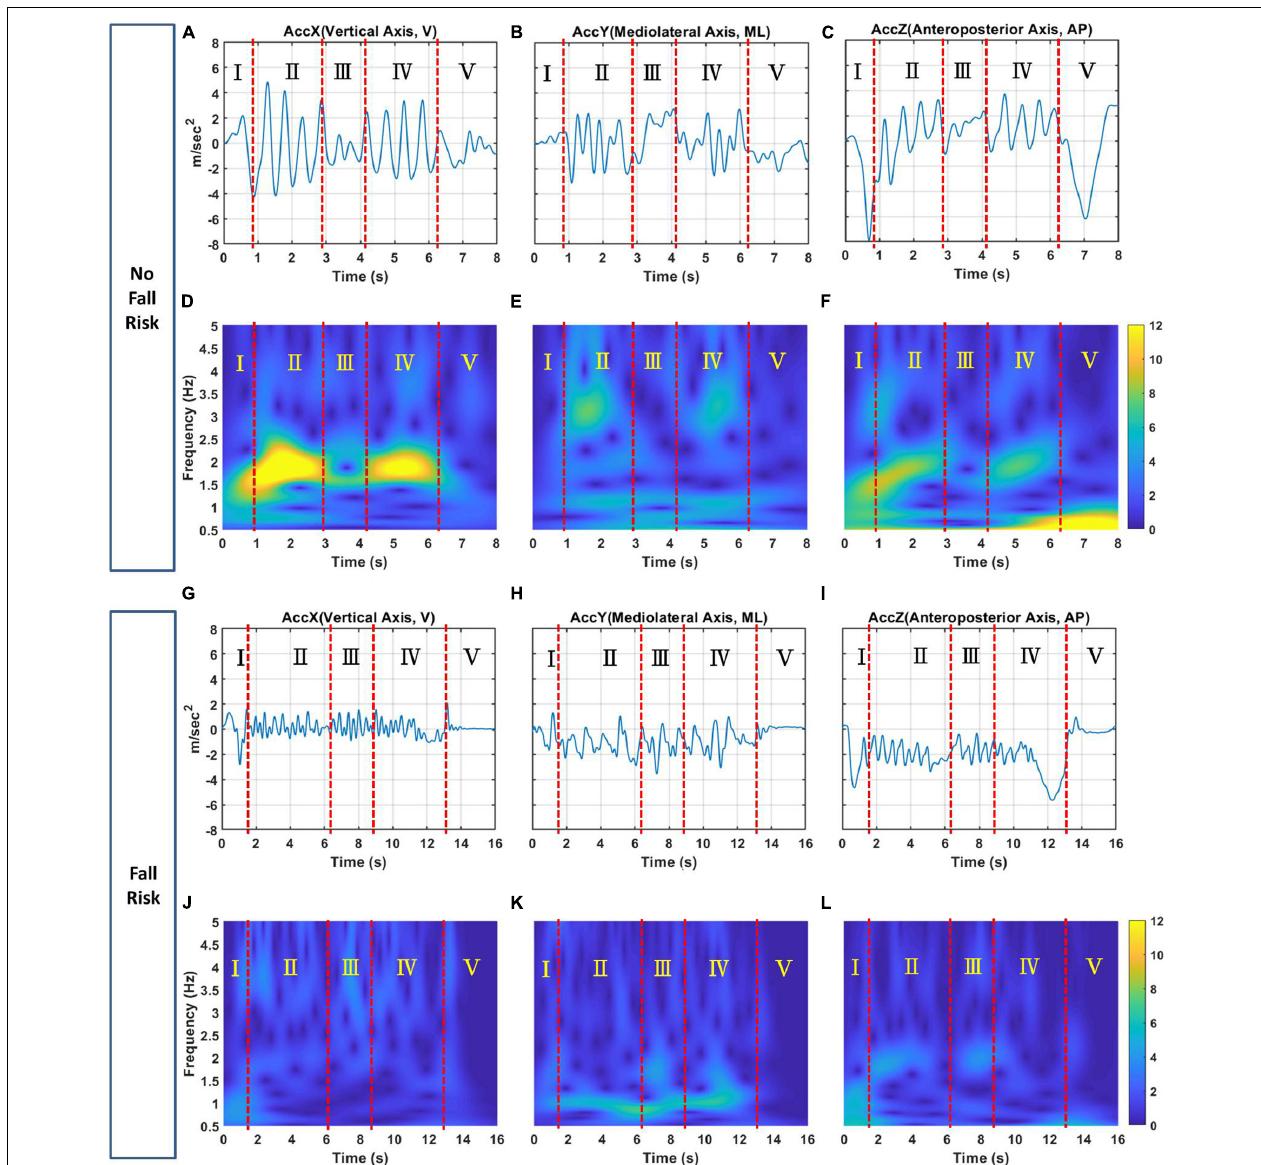
FIGURE 4 | Examples of the (A) X-, (B) Y-, and (C) Z-axis acceleration signals for a subject with no fall risk; (D–F) corresponding TF images of triaxial acceleration signals, respectively. Examples of the (G) X-, (H) Y-, and (I) Z-axis acceleration signals for a subject with a fall risk; (J–L) corresponding TF images of triaxial acceleration signals, respectively. The X-, Y, and Z-axes correspond to the V, ML, and AP directions, respectively. Zones I, II, III, IV, and V represents the sit-to-stand, walk-F, turning, walk-B and stand-to-sit phases, respectively, of TUG. The color bar represents the magnitude of the TF energy.